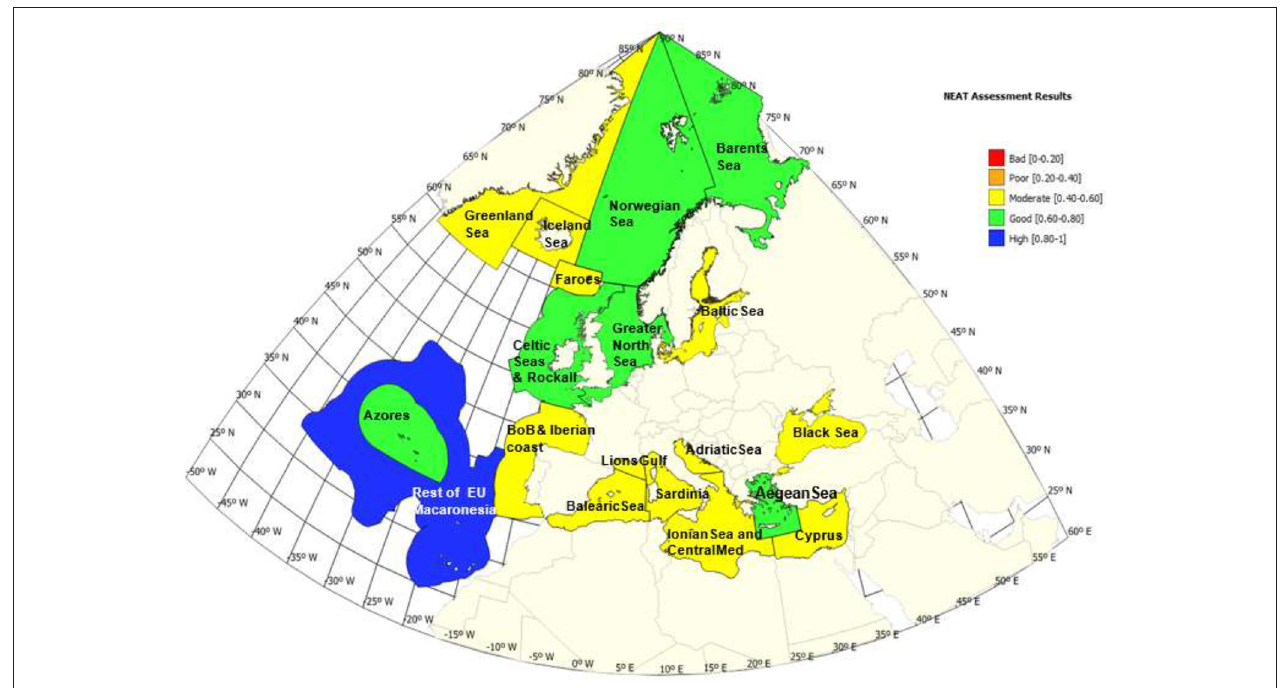
FIGURE 2 | Environmental status, for the European subregional seas, based on NEAT assessment. BoB, Bay of Biscay; EU, European